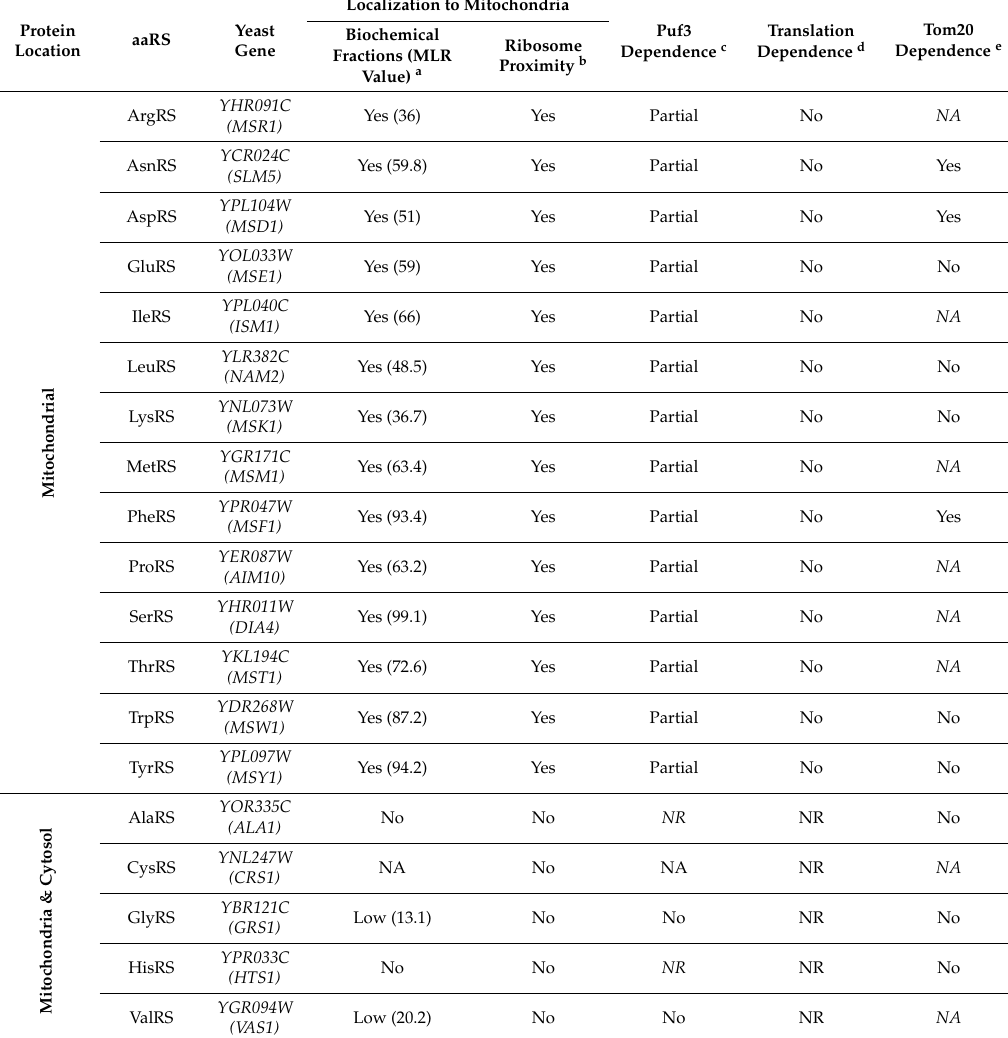
Table 1. Localization of mRNAs encoding mt-aaRSs to the mitochondria vicinity. Data collected from genome-wide RNA localization studies imply localization of mt-aaRS mRNAs to mitochondria vicinity in a translation-independent